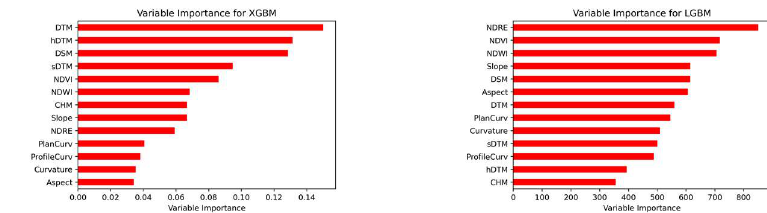
Figure 8. ROC Curves for all Gradient Boosting models on pooled data. Figure 9. Feature Importance for all Gradient Boosting Models trained on pooled data.